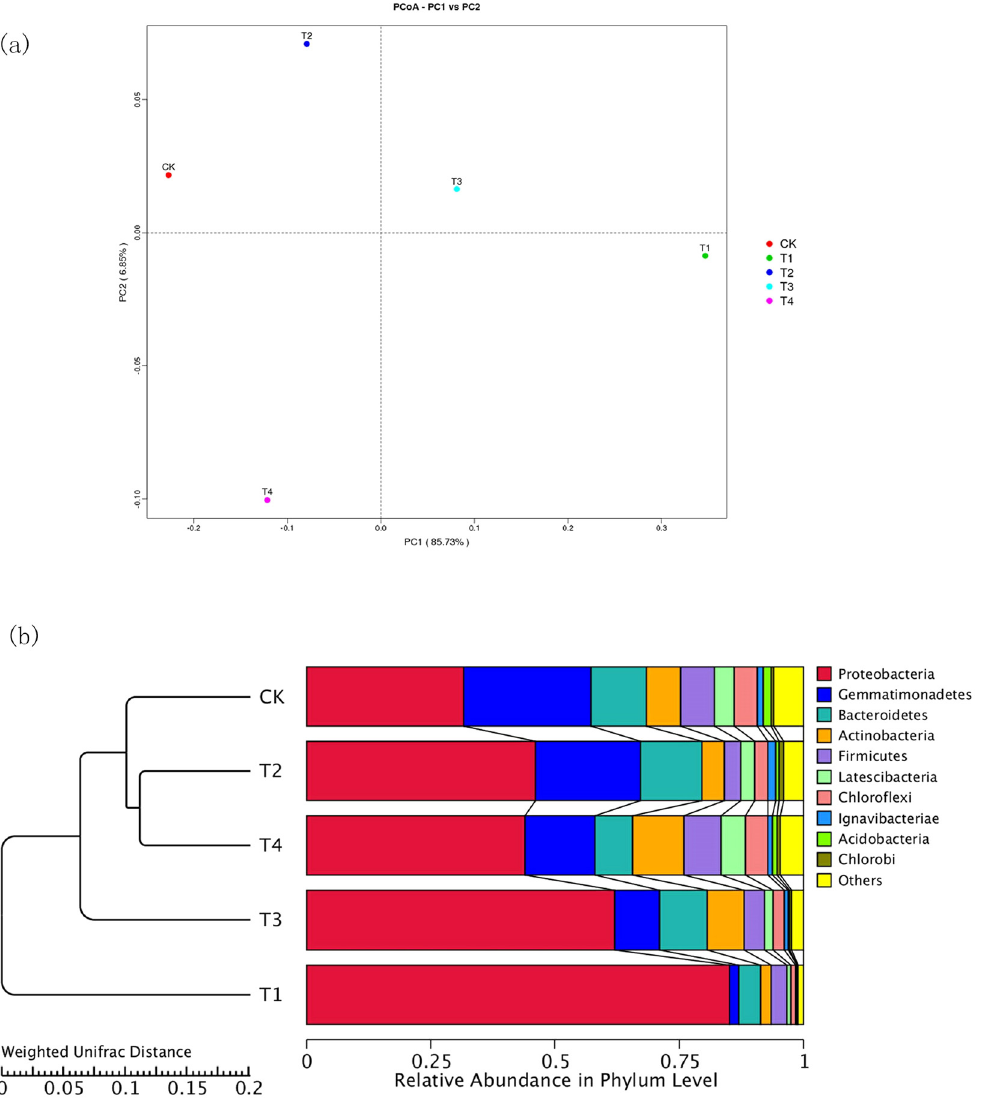
Figure 6: ( a ) Bacterial community clustering based on weighted UniFrac PCoA in vermicompost samples and ( b ) bacterial community clustering based on weighted UniFrac distances in di ff erent sampling vermicompost. The tree was calculated by weighted UniFrac distance based on relative abundances at the phylum